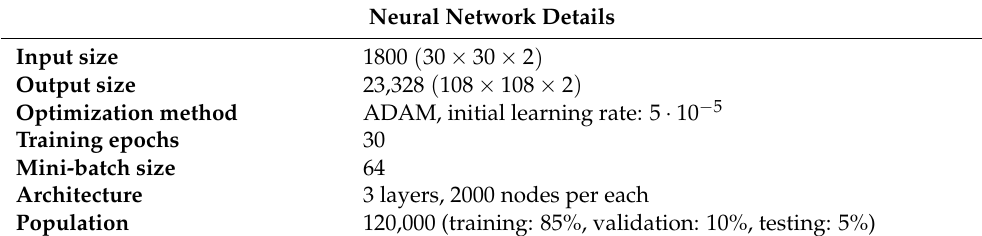
Figure 3. Sketch of the inversion procedure. The input of the fully-connected neural network is the scattering matrix E sct re-arranged in a vector form y i , i = { 1,2, . . . , M } , with M number of scattered field samples. The output of is represented by the tissues relative permittivity (cid:101) r and conductivity σ pixel by pixel x j , j = { 1,2, . . . , N } , with N number of pixels in the imaging domain. Table 3. Details on the implemented neural network